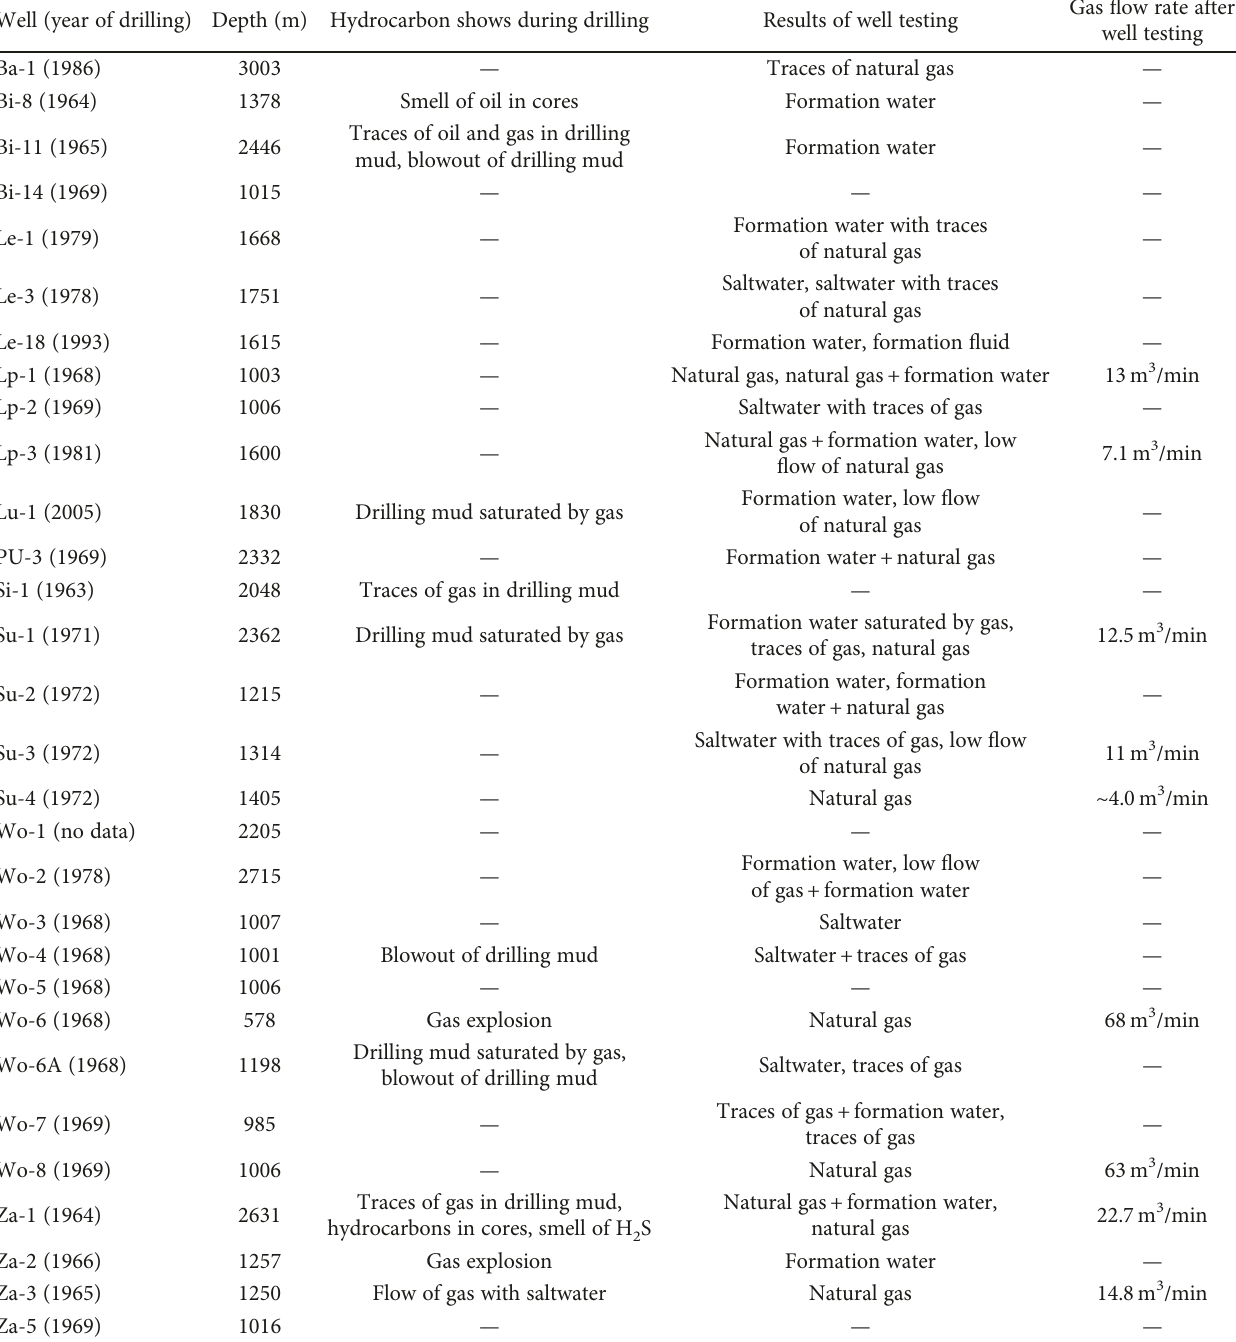
Table 2: Hydrocarbon shows during the drillings and the results of well tests (after unpublished data of the POGC). Well (year of drilling) Depth (m) Hydrocarbon shows during drilling